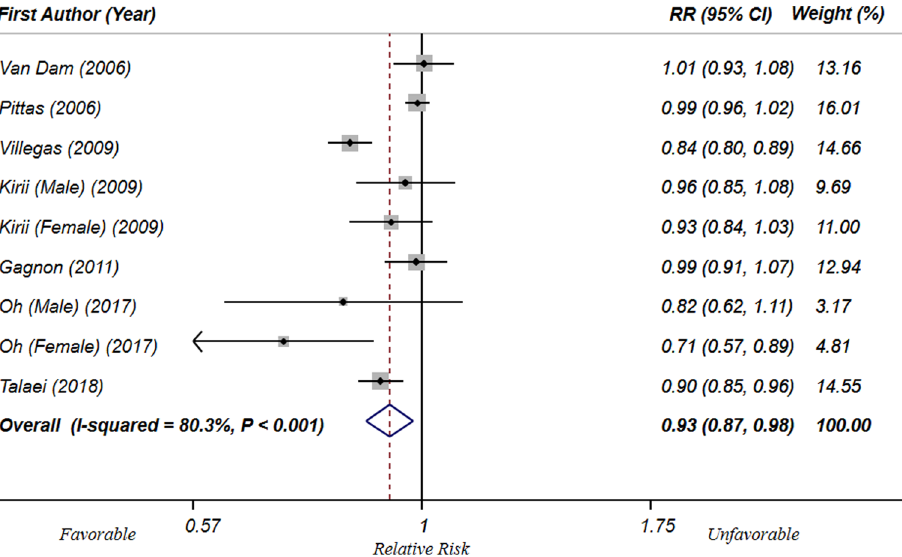
Figure 3. Forest plots of linear dose–response meta-analysis of the association between each 300 mg/day increment in dietary Ca intake levels and T2DM in prospective cohort studies with representative adult